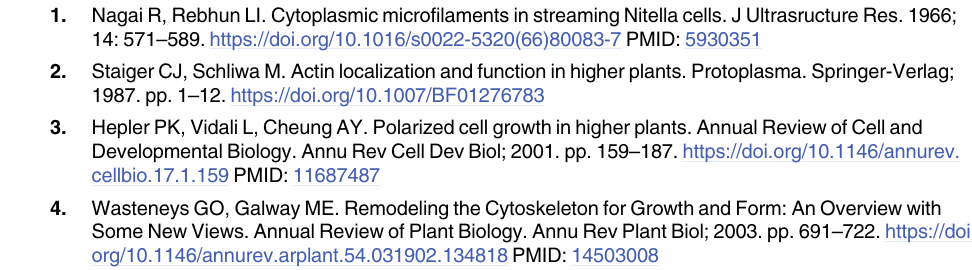
S2 Fig. Expression and localization of XI-K-GTD. Expression intensity of XI-K-GTD and DCP1 was measured in Col-0 midvein cells transiently expressing YFP-XI-K-GTD and DCP1-CFP with or without XI-K -DCP2. The error bars depict the standard deviation. Δ GTD Significance was determined with a two-sided t-test at p < 0.001 ( ��� ), p < 0.01 ( �� ), and p < 0.05 ( � ). S1 Table. Primer list. S2 Table. Wilcoxon test with multiple testing correction of P-body motility in myosin sin- gle mutants and under the dominant negative effect of myosin fragments in Arabidopsis thaliana leaf midvein cells. Significance was determined with a two-sample test at p < 0.001 ( ��� ), p < 0.01 ( �� ), and p < 0.05 ( � ). S3 Table. Wilcoxon test with multiple testing correction of P-body speed data, collected by manual tracking of DCP1-CFP marked P-bodies in transiently transformed Arabidopsis thaliana leaf midvein cells. Significance was determined with a two-sample test at p < 0.001 ( ��� ), p < 0.01 ( �� ), and p < 0.05 ( � ).